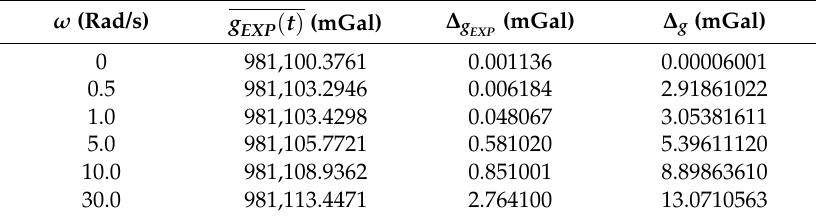
Table 4. SE errors caused by vibrations of the base at p = 0.90.